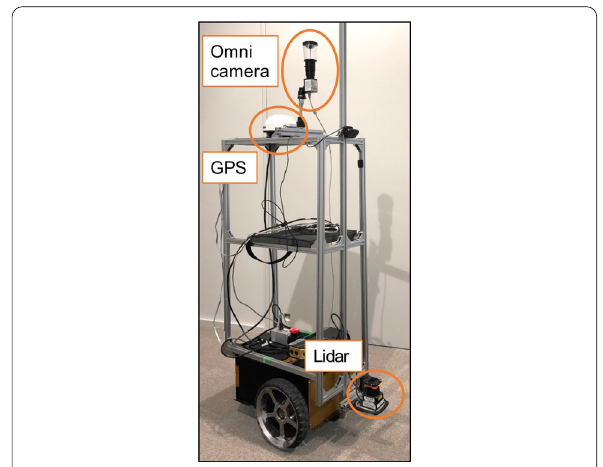
Fig. 5 Robot with GPS, omni camera, and